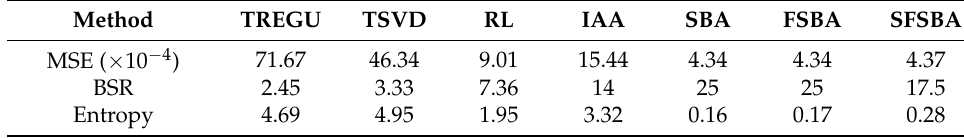
Table 3. Performance index of simulation